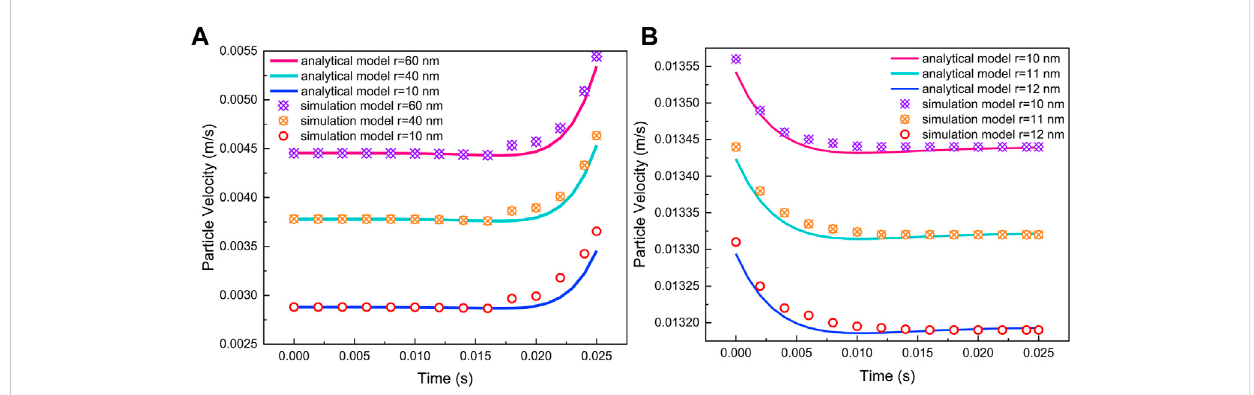
FIGURE 8 Comparison of particle velocities solved by the analytical model and simulation model for (A) convergent and (B) divergent fl ow path